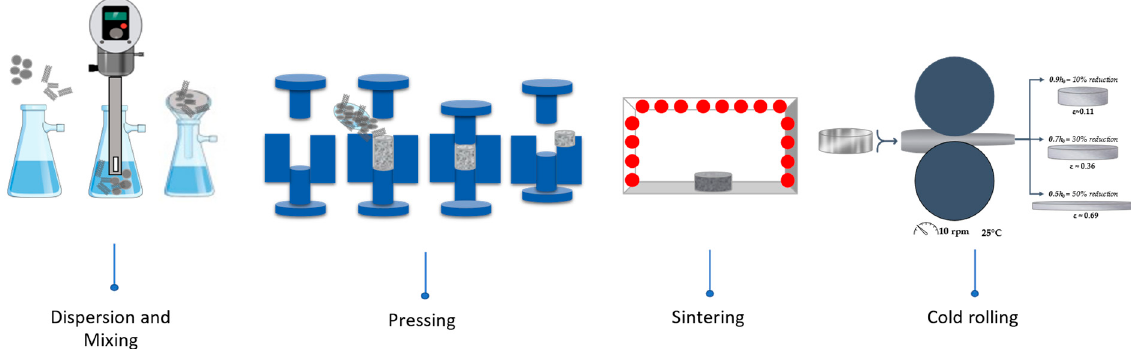
Figure 3. Schematic representation of the production steps used in Al matrix and Al/CNTs nano- composites.